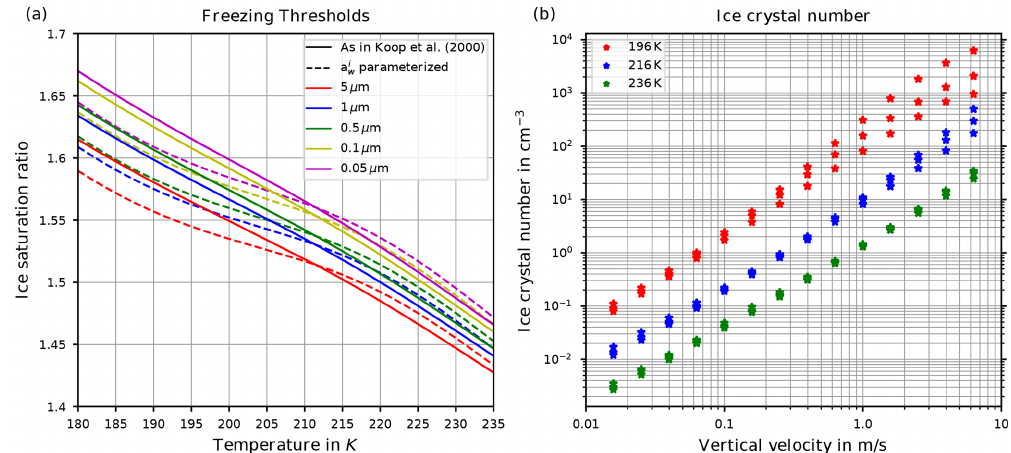
Figure 1. (a) Freezing thresholds as computed in Koop et al. (2000, reproducing their Fig. 3) as a function of temperature for various radii of the solution particles. The solid lines are based on the formulation a i w ( T ) = p i , sat ( T ) for the water activity of ice a i w , where p i , sat is p sat , MK ( T ) the saturation vapor pressure of ice and p sat , MK is the saturation vapor pressure of liquid water, both according to the formulations given in Murphy and Koop (2005). The dashed lines use the formulation of a i w as given in Koop et al. (2000, their Eqs. 1 and 2) and are converted into a saturation ratio with the help of the formulations p i , sat and p sat , MK from Murphy and Koop (2005). (b) Number concentration of homogeneously nucleated ice crystals as given in Kärcher and Lohmann (2002, reproducing their Fig.